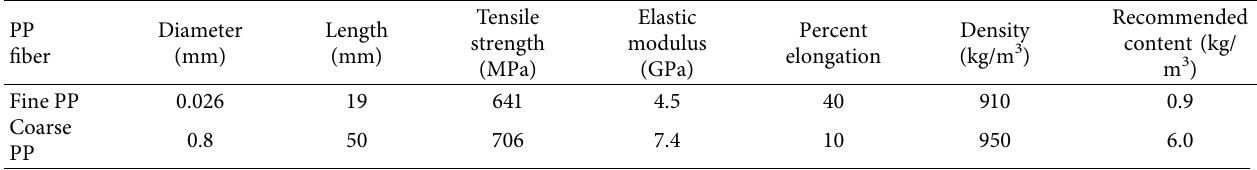
Table 1: Physical-mechanical indices of polypropylene fibers.